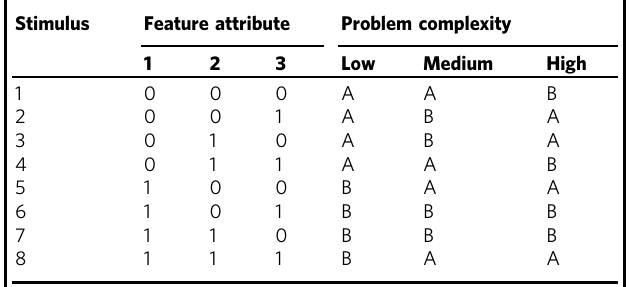
Table 1 Stimulus features and class associations for the three learning